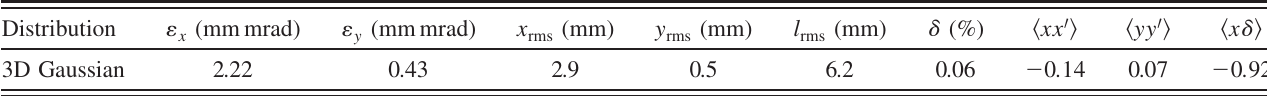
TABLE I. Initial conditions of the 72 MeV transfer line for a 2 mA cw beam. The emittances are non-normalized. The term h xx 0 i is p , where C ð x; x 0 Þ is the covariance of x and x 0 . It is the same for h yy 0 i the correlation coefficient which is defined as h xx 0 i ¼ C ð x;x 0 Þ ffiffiffiffiffiffiffiffiffiffiffiffiffiffiffiffiffiffiffiffiffiffi ð C ð x;x Þ C ð x 0 ;x 0 Þ and h x(cid:9) i